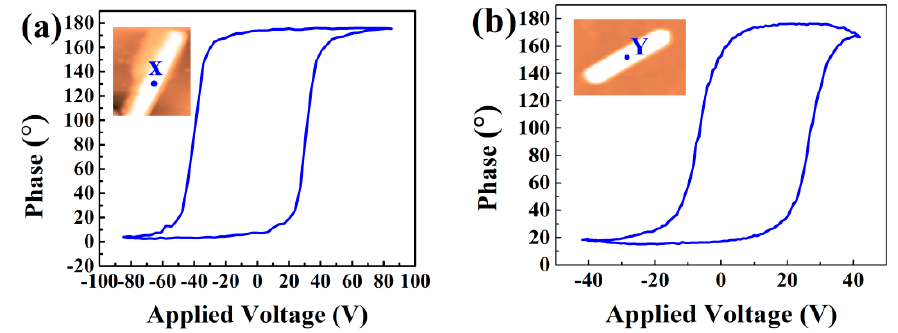
Figure 4. The local phase hysteresis loops of the BFO NWs (( a ) corresponds to the NW in Figure 2a, while ( b ) corresponds to the NW in Figure 2b, and test points are marked in the inserted figure).